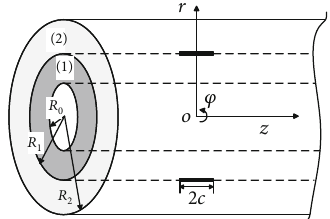
Figure 1: A composite tube with a cylindrical interface